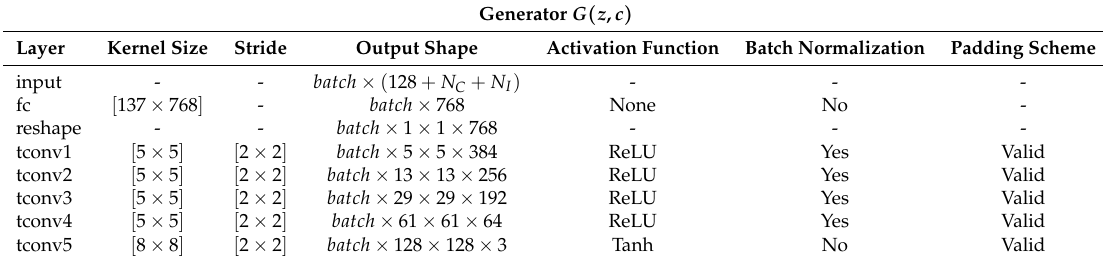
Table A2. Generator network architecture details.